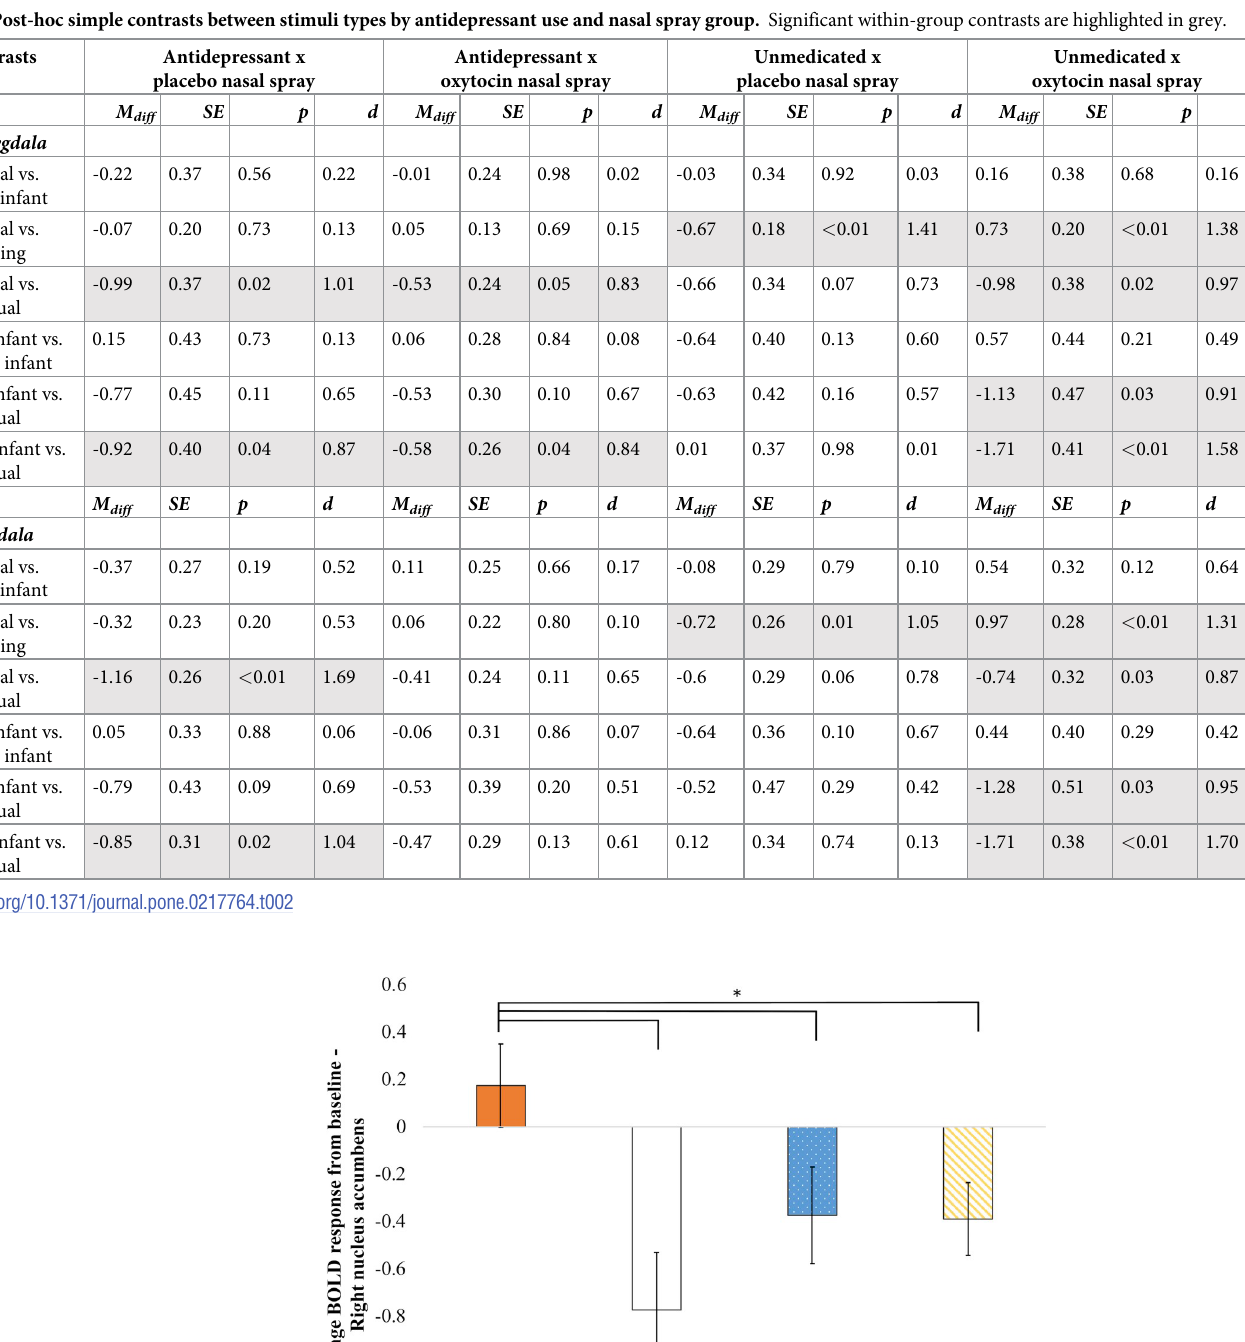
Antidepressant x oxytocin nasal spray